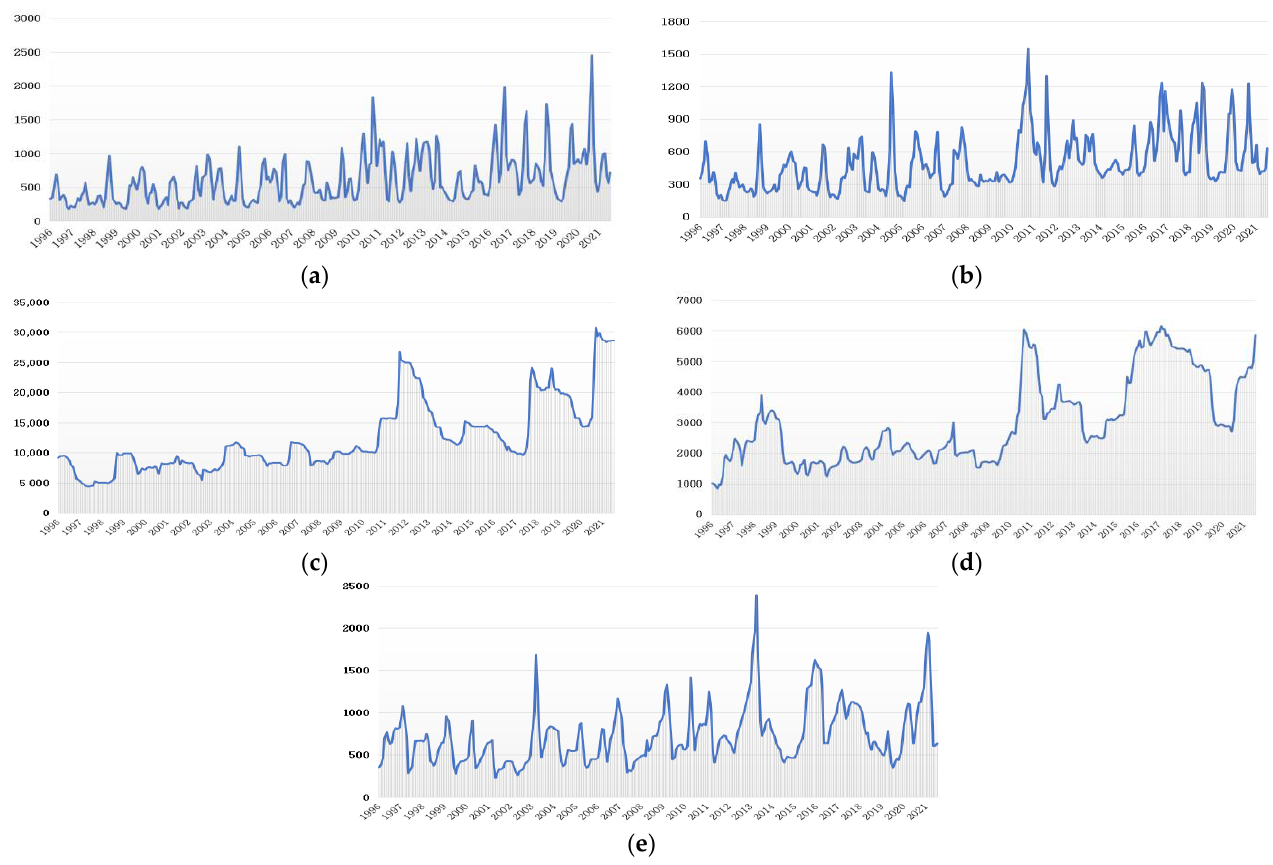
Figure 1. Monthly Wholesale Prices of Major Vegetable Crops in South Korea (in KRW/kg). Source: KAMIS (Korea Agro-Fisheries and Food Trade Corporation). ( a ) Cabbage; ( b ) Radish; ( c ) Dried Red Pepper; ( d ) Garlic; ( e ) Onion.